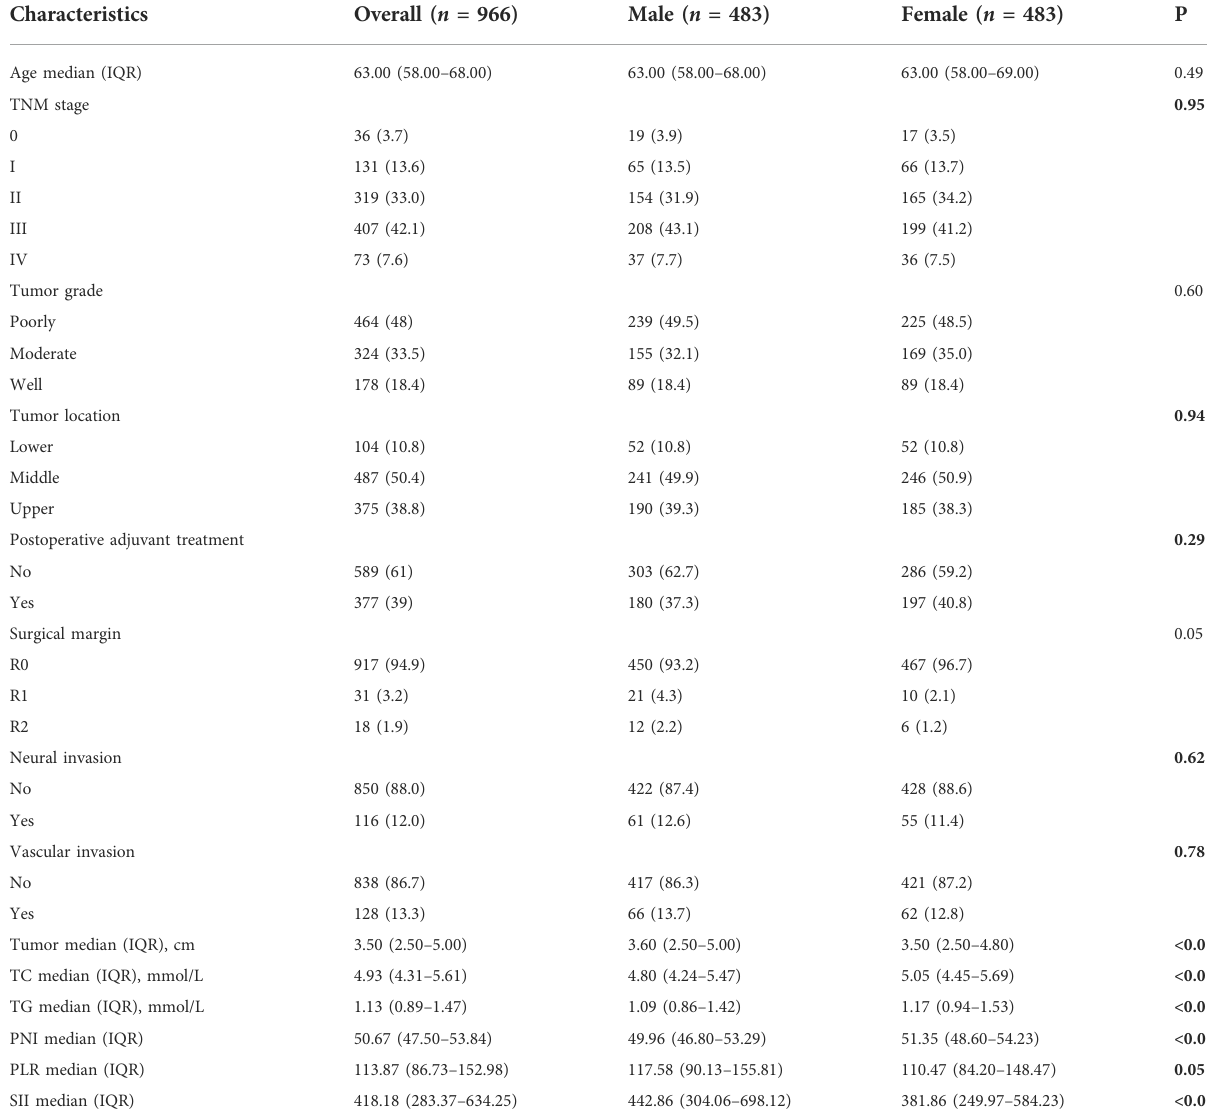
TABLE 3 Patient characteristics of the total cohort after